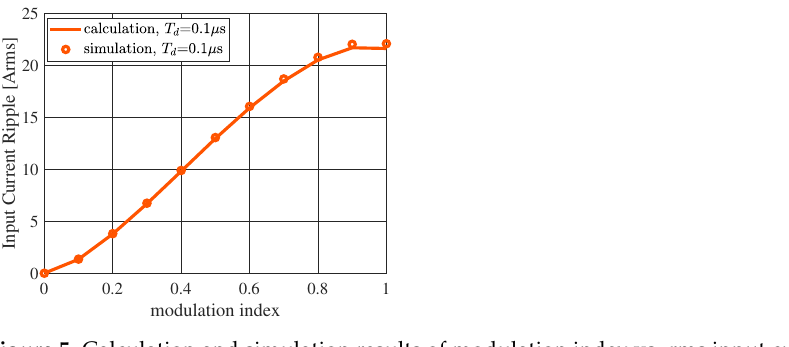
Figure 5. Calculation and simulation results of modulation index vs. rms input current ripple of the three-phase VSI (case 1 load, T d = 0.1 µ